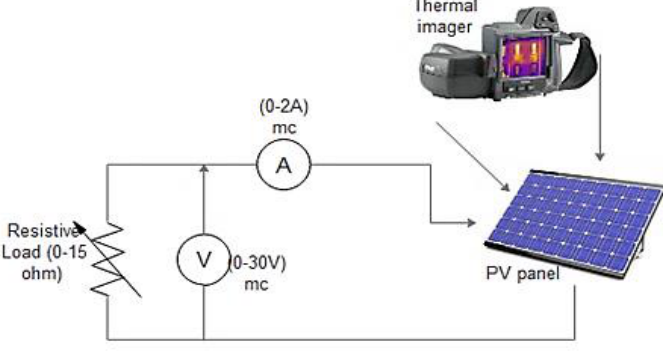
Figure 2. Schematic diagram of the experimental setup.